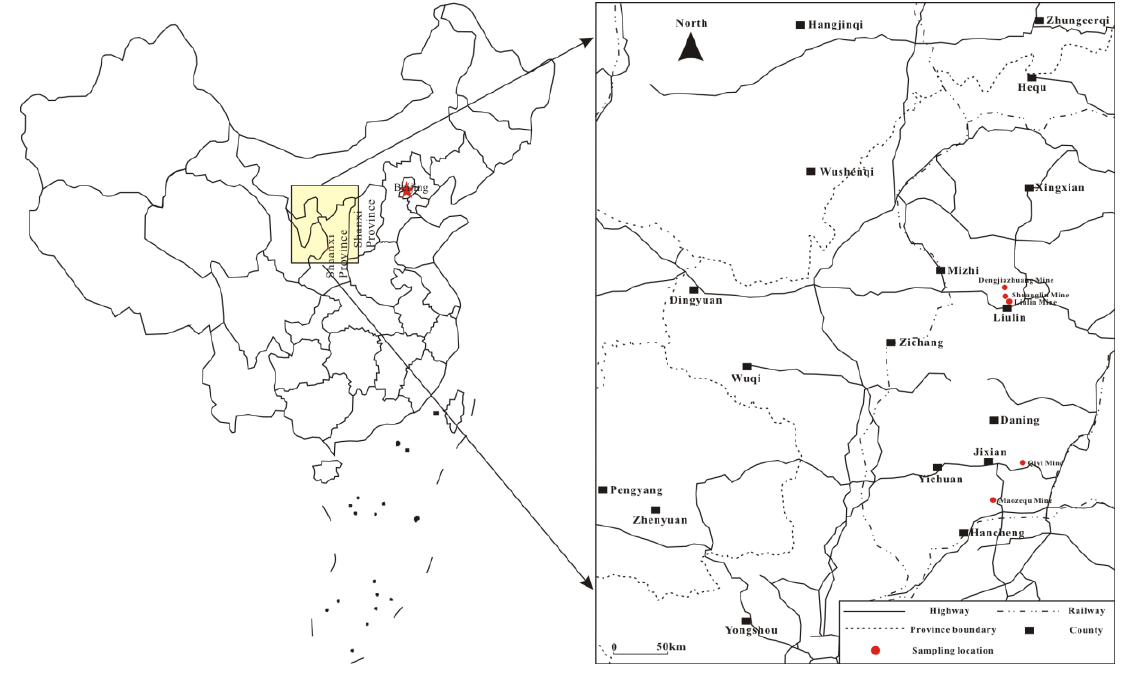
Figure 1. Location of coal samples collected.